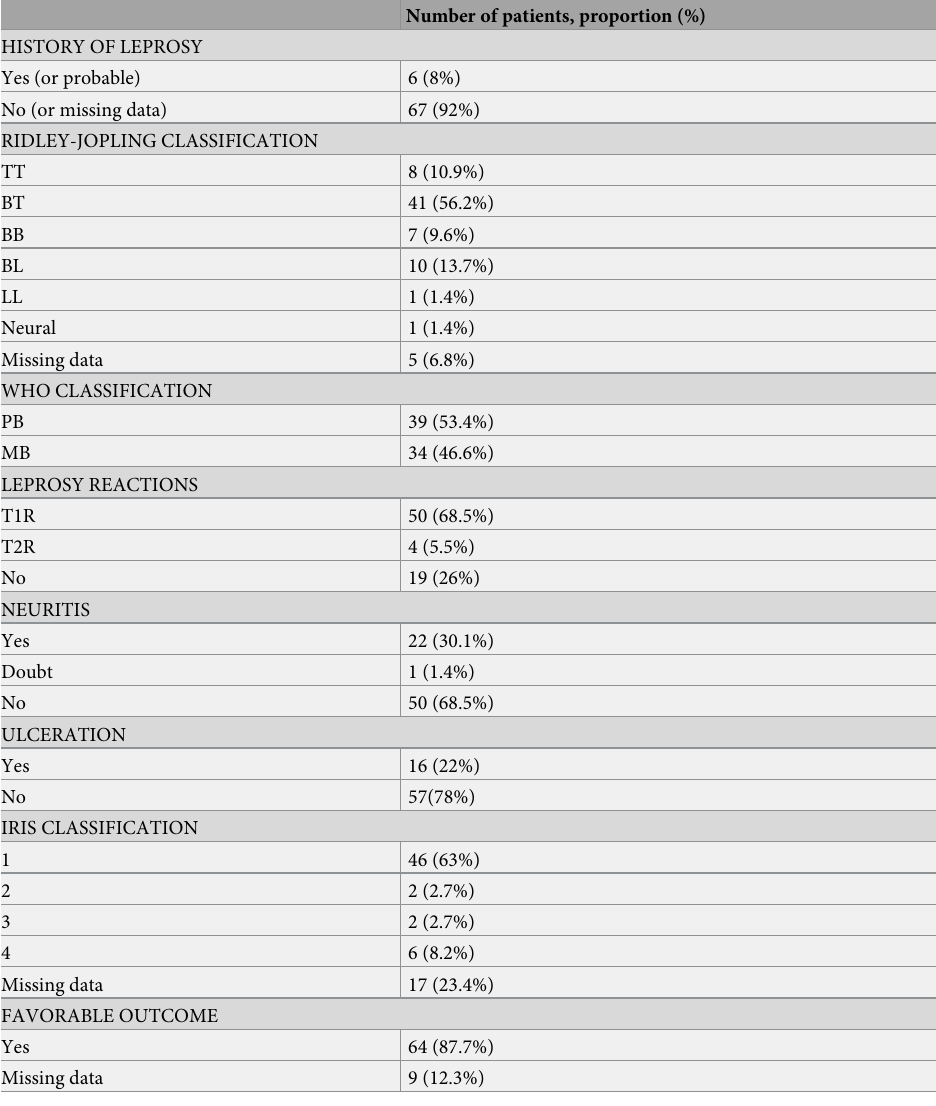
Table 2. Number and proportion of patients diagnosed with leprosy IRIS included in the systematic review. Number of patients, proportion